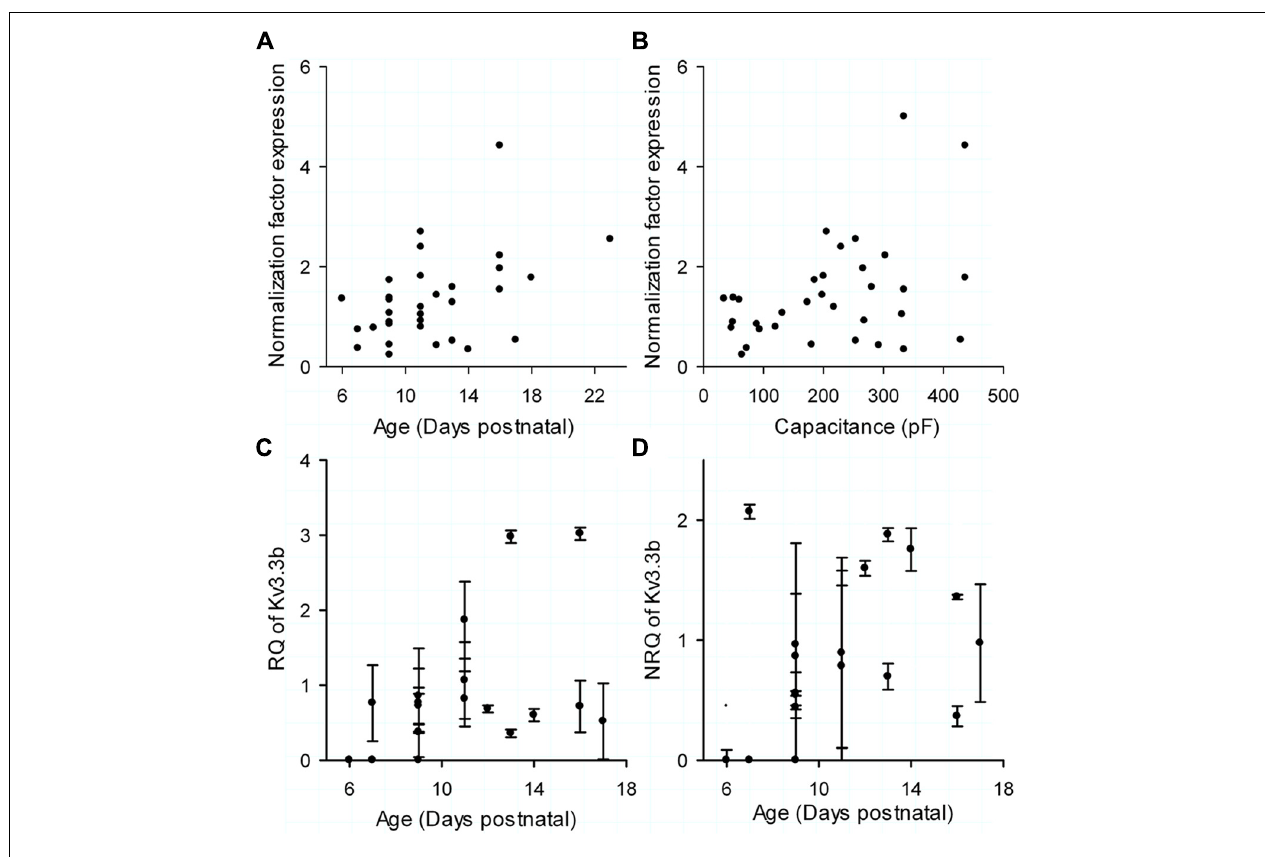
quantity (NRQ) of Kv3.3b of each cell, calculated by dividing RQ (C) by NF (A,B) versus postnatal age. The error bars in (C,D) were determined through calculating the error propagation of the normalized or non-normalized relative quantity of the Kv3.3b real time PCR